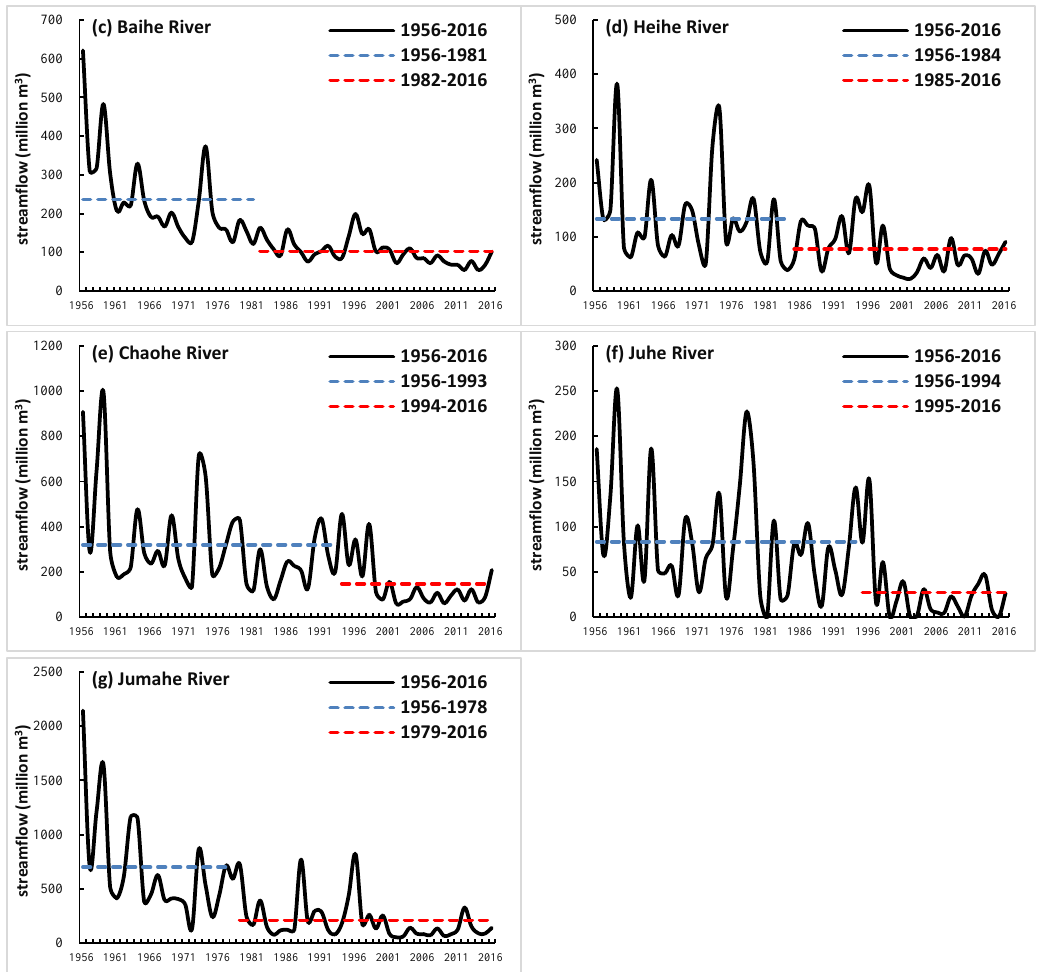
Figure 3. Mean annual streamflow change of the different rivers ( a – g ) over the period 1956–2016. The dashed lines indicate multi-year averages over the different periods.